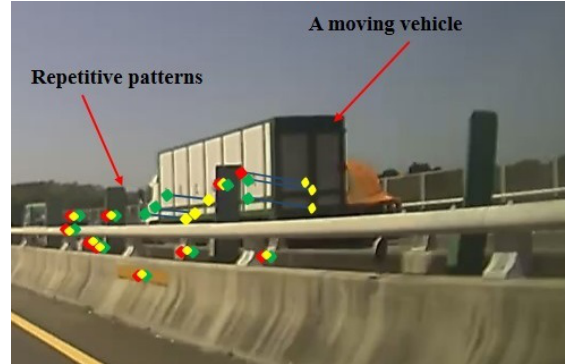
Figure 11. An illustration of messy optical flow when repetitive patterns occur, which result in the forward and backward feature tracking inconsistency.